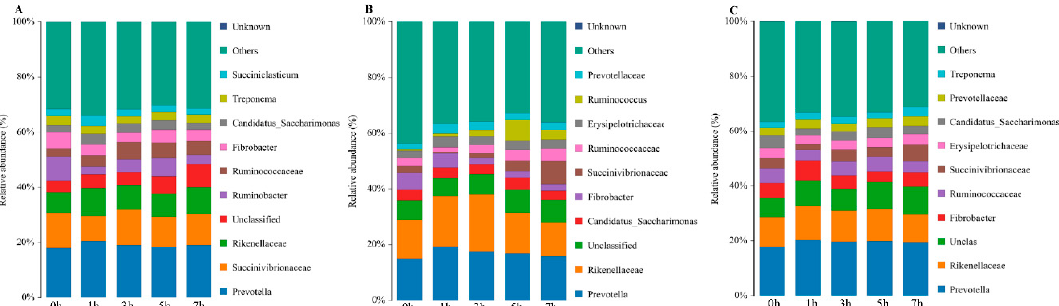
Figure 3. Community composition of bacteria at the tax level of genus in different times. ( A ) CSG. ( B ) MG. ( C ) OHG.